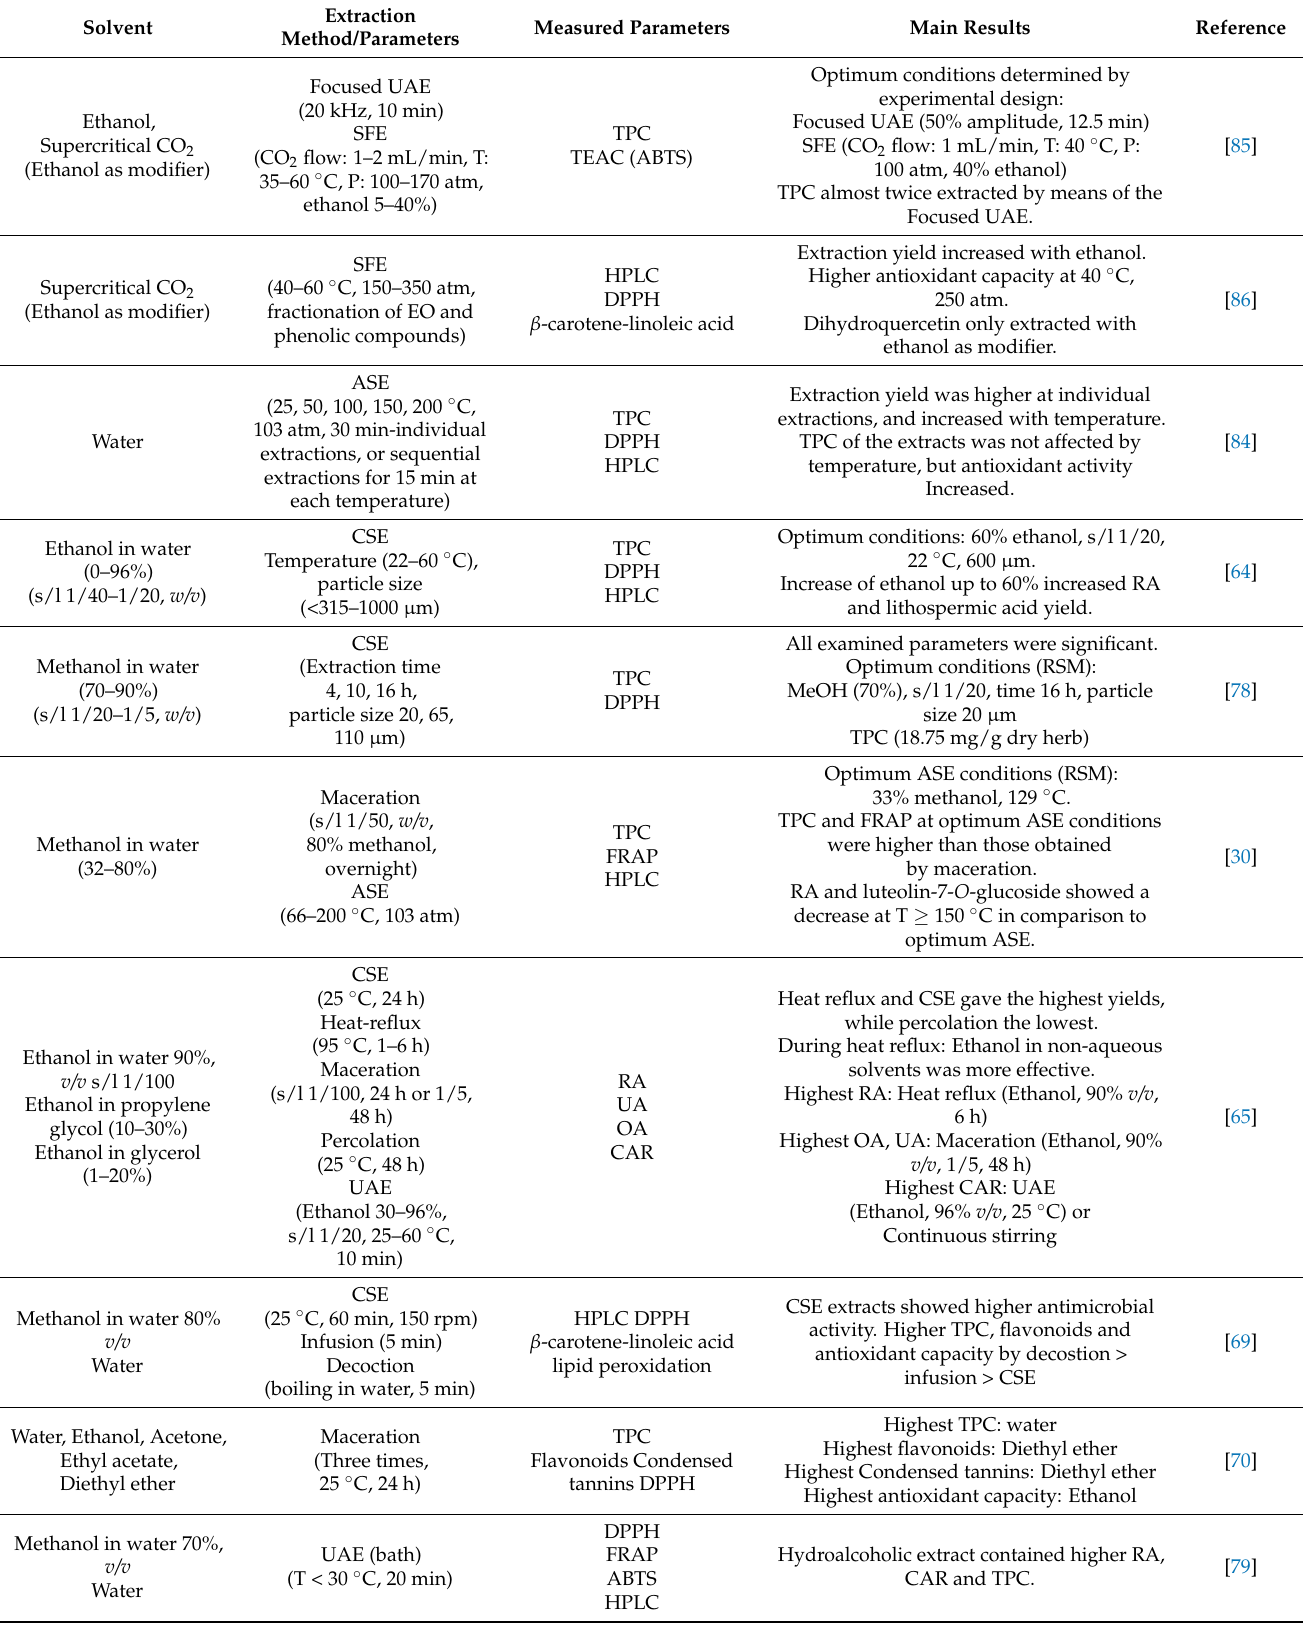
Table 2. Solvents and methods reported in literature for the extraction of phenolic compounds from oregano.